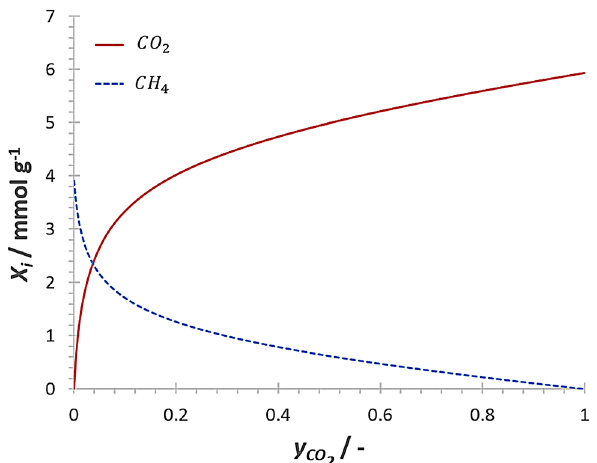
(red) and CH (blue) on 2 4